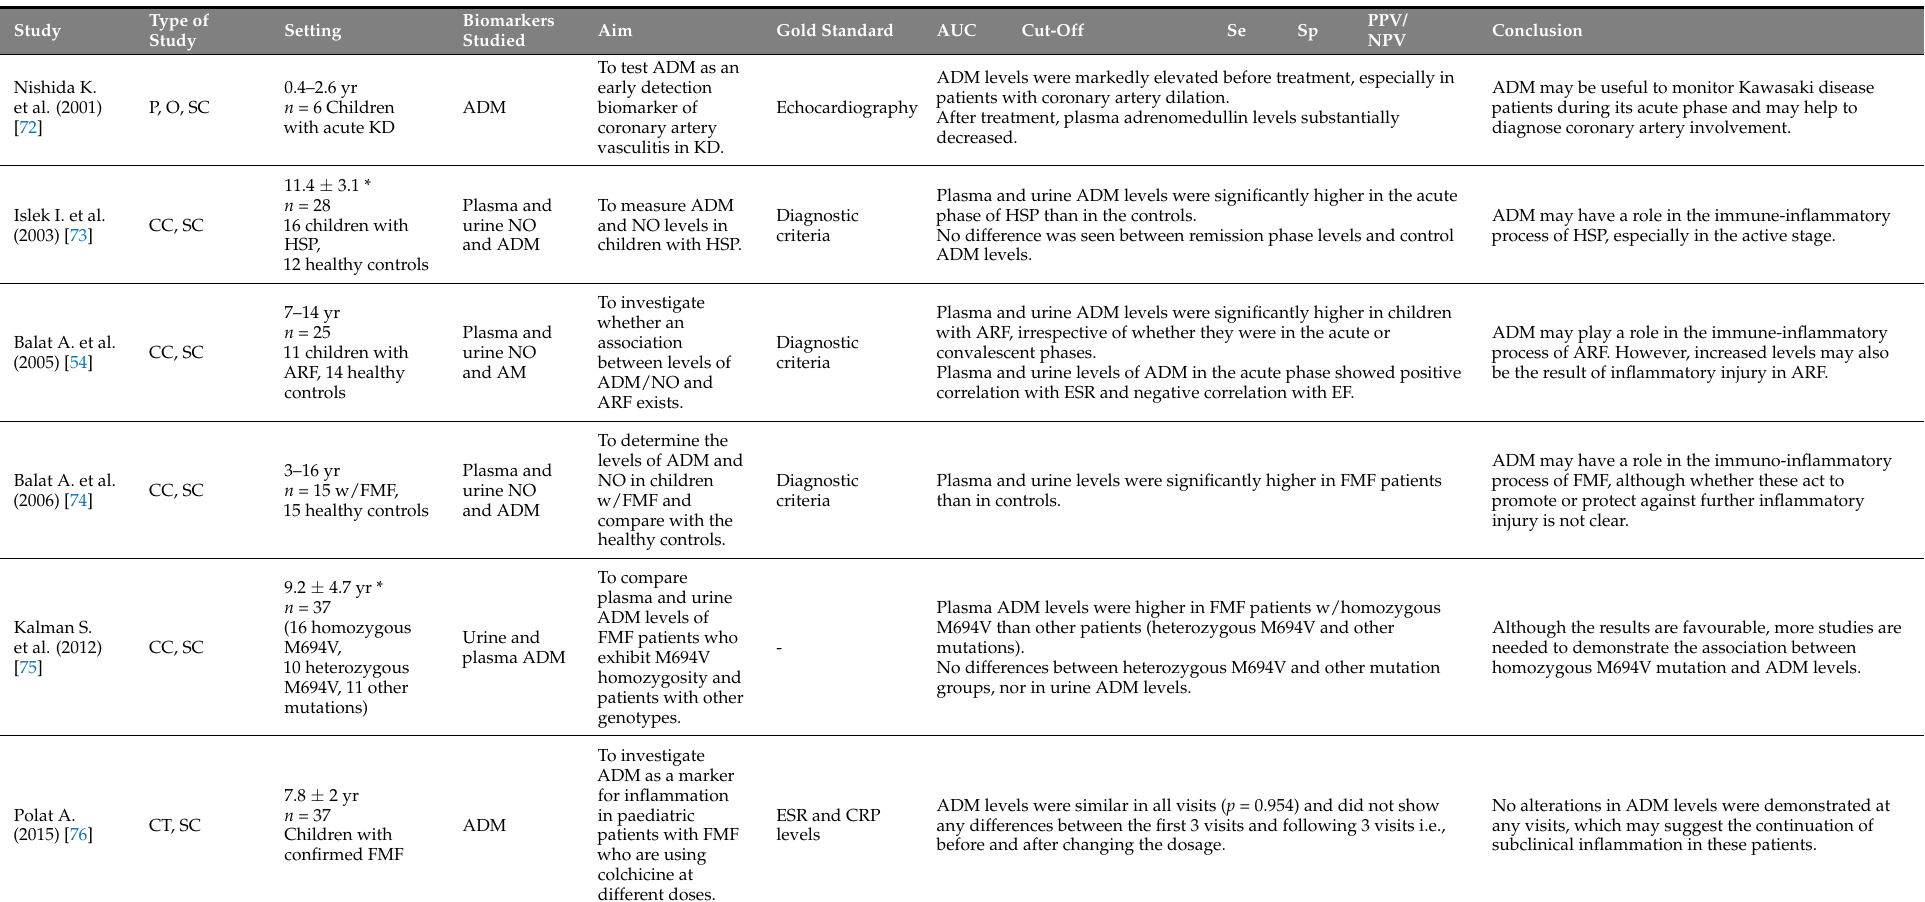
Table 6. Adrenomedullin and rheumatic